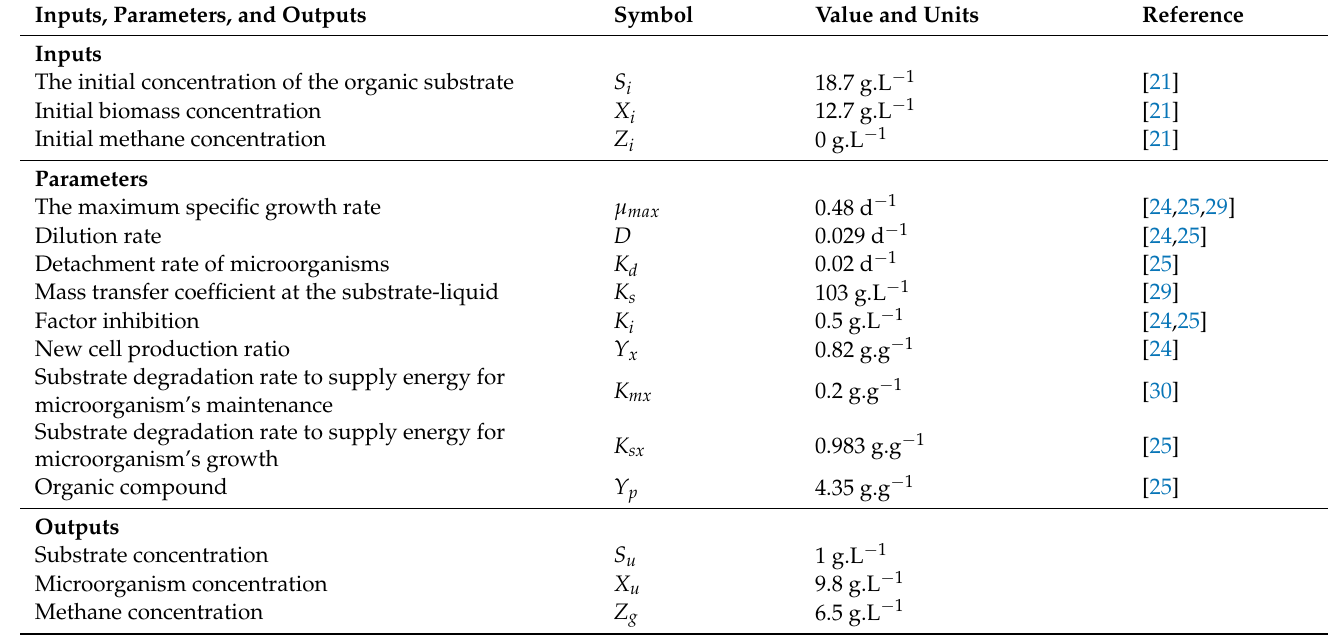
Figure 2. Screenshot of the INSEL block for simulation of anaerobic digester function. Table 1. List of inputs, parameters, and outputs of the